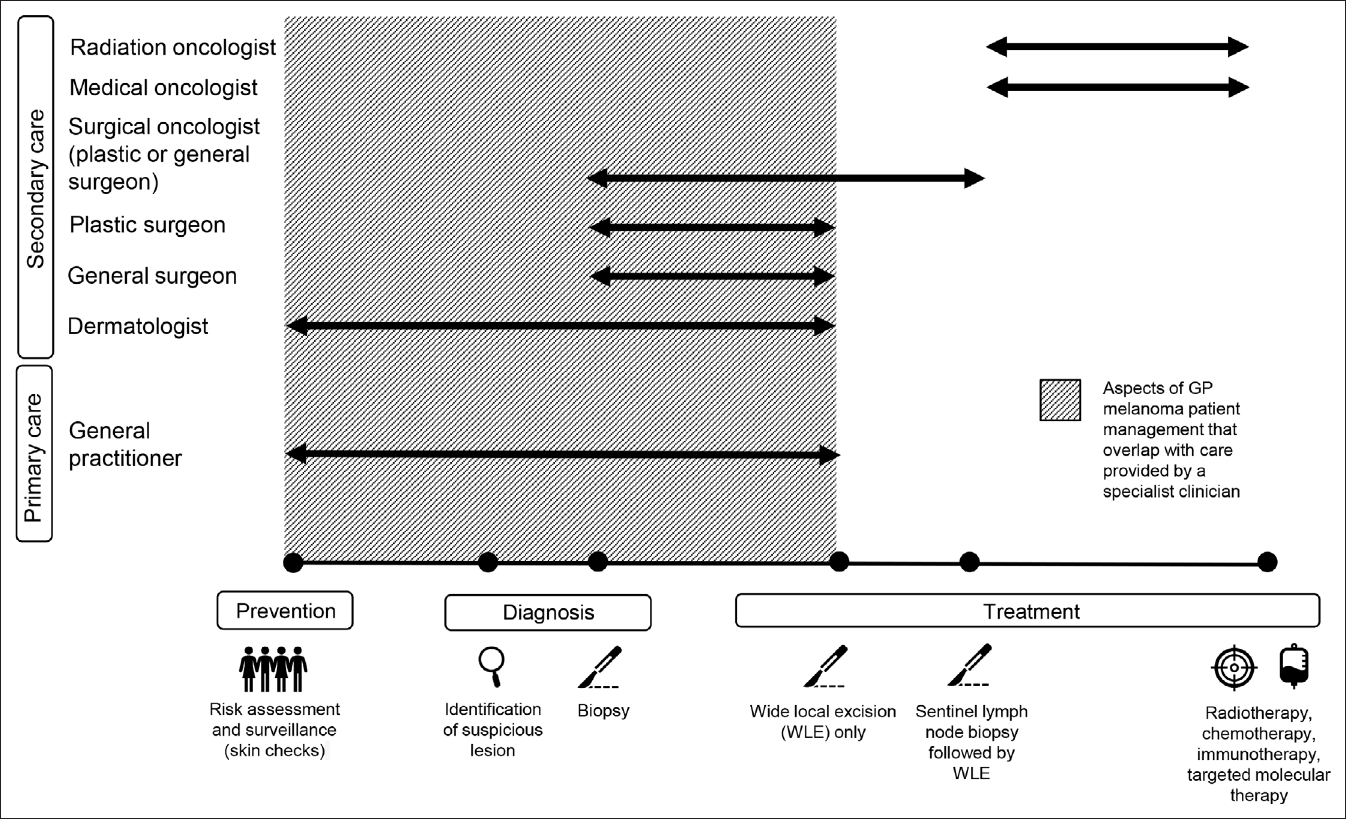
Figure 2 GP and specialist roles in melanoma management in